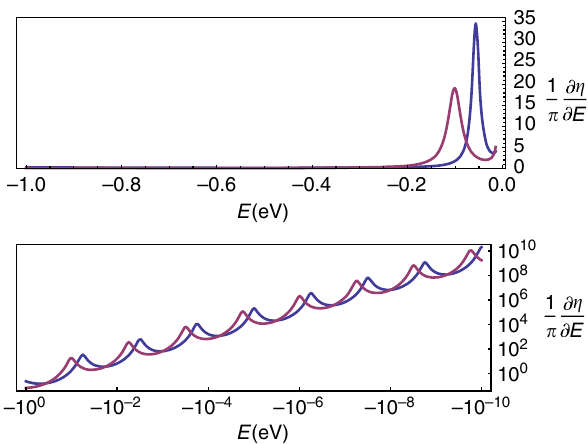
Fig. 3 Theoretical behavior of the low energy and scale-free part of the quasi-bound states spectrum in the overcritical regime for d = 2 and β = 1.2 > β = 1/2). The lower plot displays the detailed structure of the c ( in fi nite geometric ladders. Note that the m = − 1 ( blue ) and m = 0 ( purple ) ladders are intertwined. These results are independent of the boundary